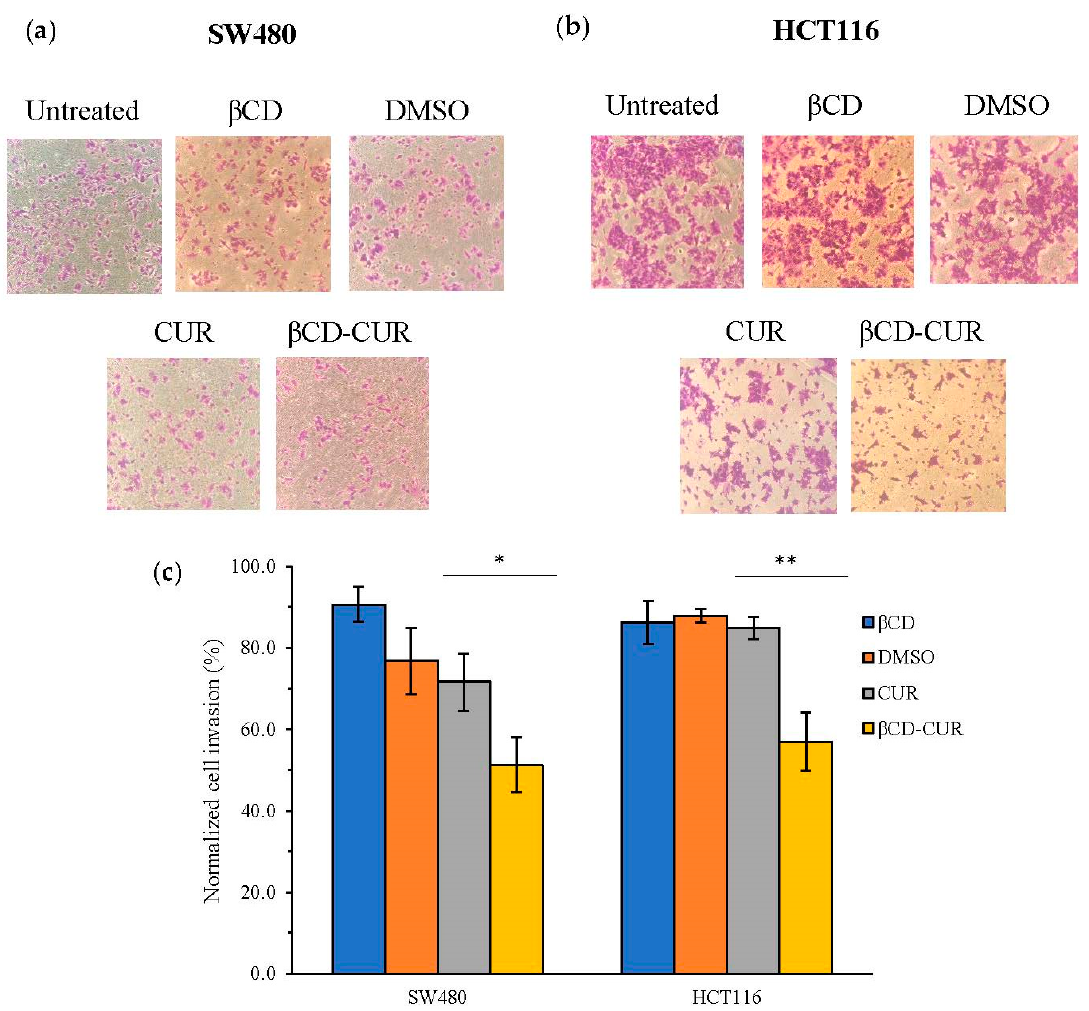
Figure 6. The inhibition effects on cell invasion as assessed by transwell assay. Representative images of invaded cells stained with crystal violet on the bottom membrane of Matrigel transwell invasion insert for ( a ) SW480 cells and ( b ) HCT116 cells at 200× magnification. ( c ) Bar graphs represent the normalized average number of invaded cells per field of SW480 and HCT116 cells. Quantified data were expressed as the mean ± S.D. from three independent experiments. Statistically significant differences in comparison between CUR and β CD-CUR are denoted with a p < 0.05 (*) and p < 0.01 (**).